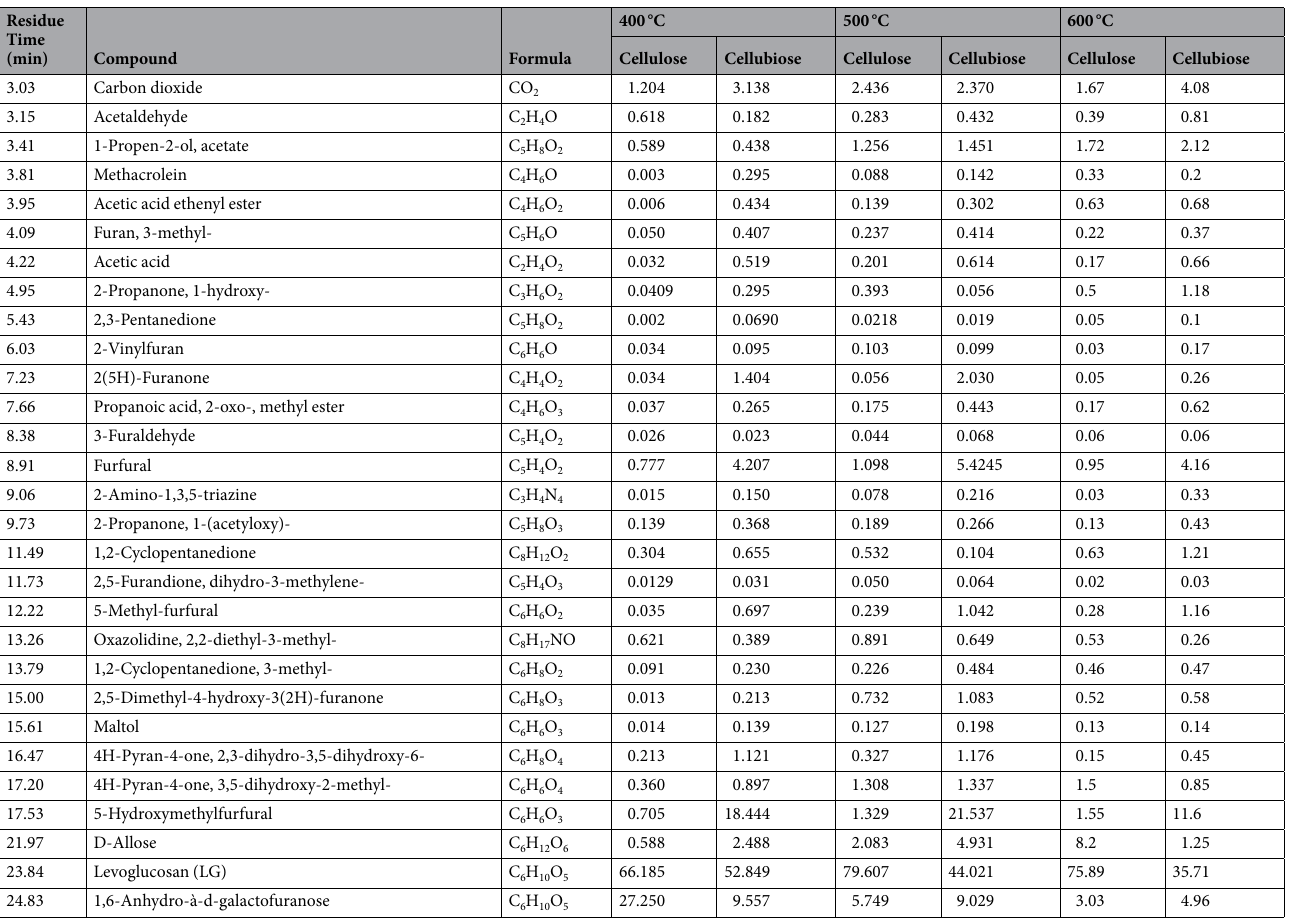
Table 1. Main products of rapid pyrolysis of cellulose and cellobiose (% in relative area).